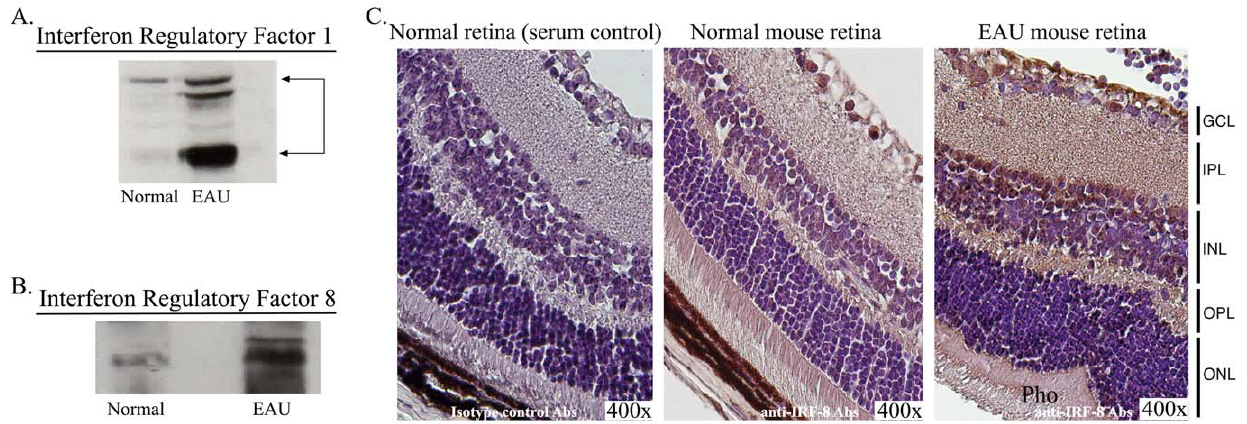
Figure 6. Detection and localization of IRF-1 and IRF-8 proteins in the retina. Retinas were isolated from control or EAU mice and whole cell extracts were analyzed for IRF-1 (A) or IRF-8 expression by Western blot analysis. (C) Immunohistochemical localization of IRF-8 expression was detected in the normal mouse retina or retina of mice with EAU using an IRF-8-specific antibody as described in Methods section. Retina pigmented epithelium (RPE); Photoreceptors (pho); outer nuclear layer (ONL); outer plexiform layer (OPL); inner plexiform layer